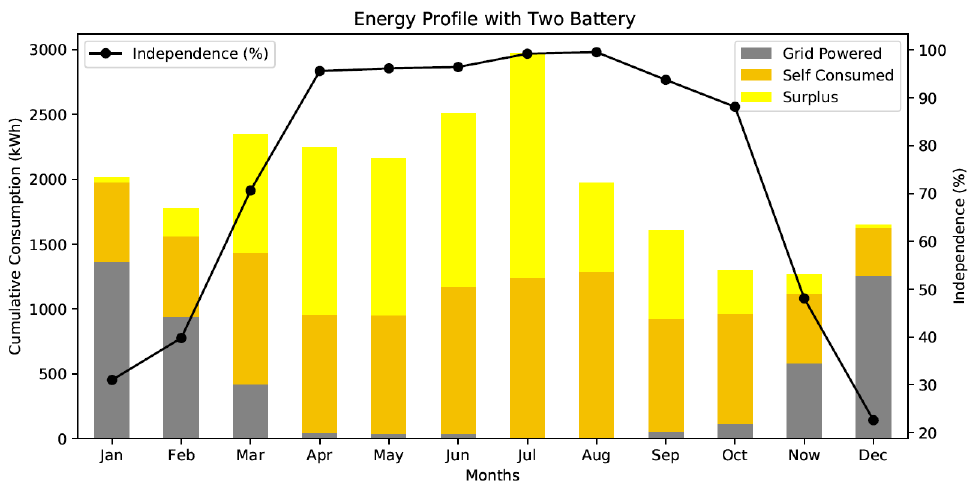
Figure 15. Energy production and consumption results with two batteries.